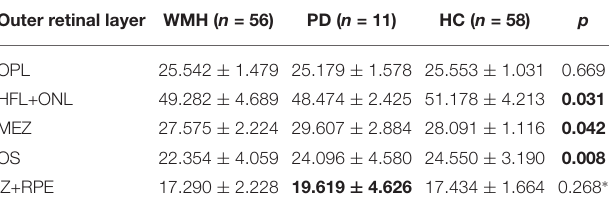
TABLE 2 | Thickness comparison among WMH, PD, and HC ( µ m